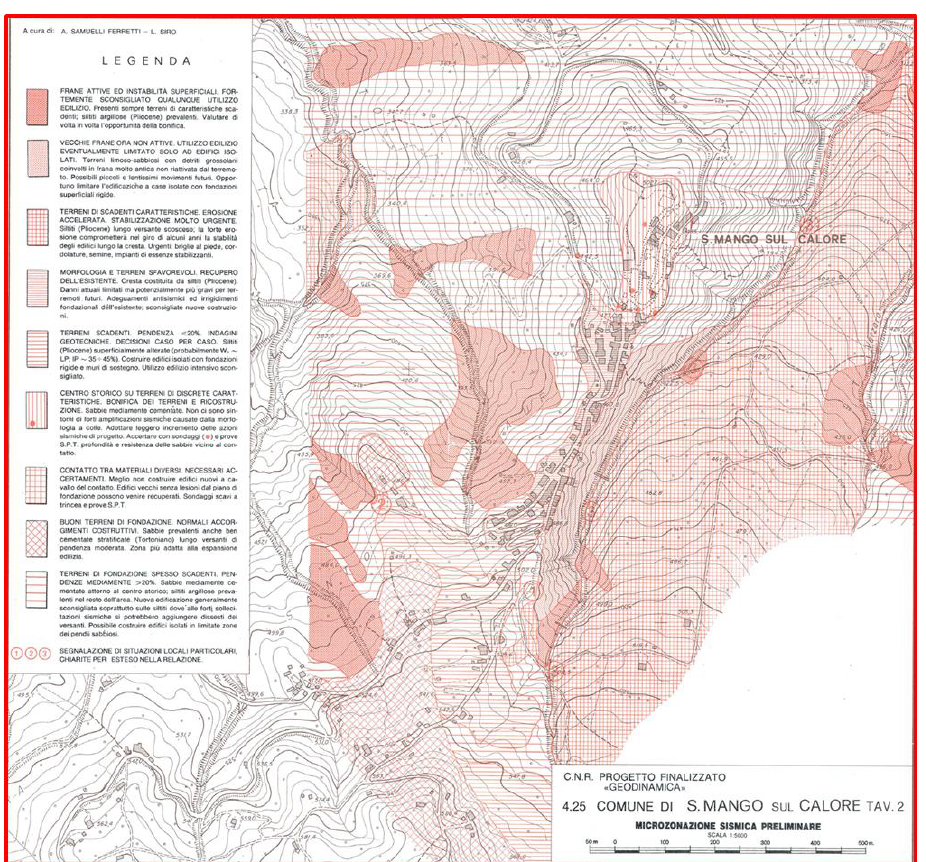
Figure 54. Original map of the seismic microzonation of San Mango sul Calore according to [29].